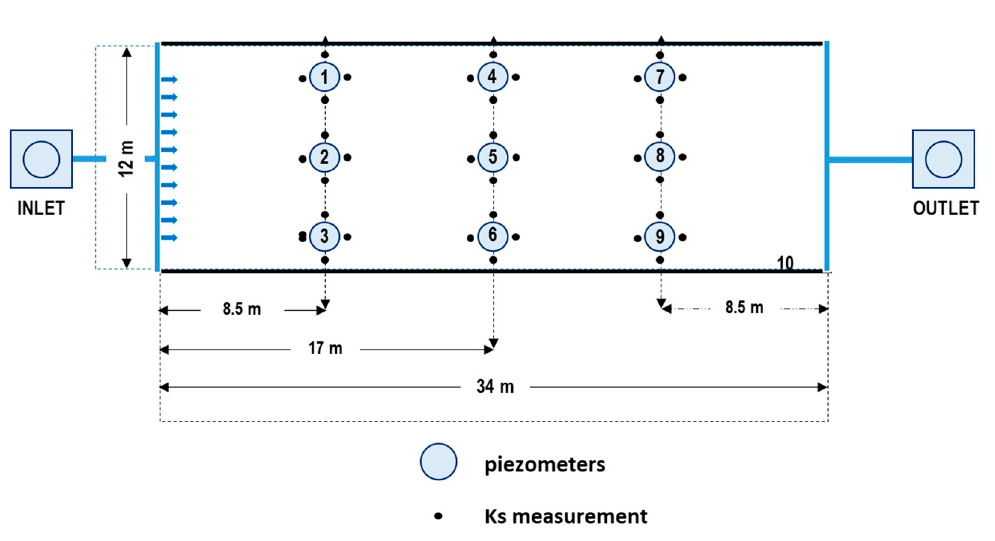
Figure 2. Layout of the horizontal subsurface treatment wetlands (HSTW) bed of the secondary wastewater treatment system of the IKEA ® store, located in Catania (Sicily, Italy), showing the location of piezometers and saturated hydraulic conductivity (Ks) measurements.